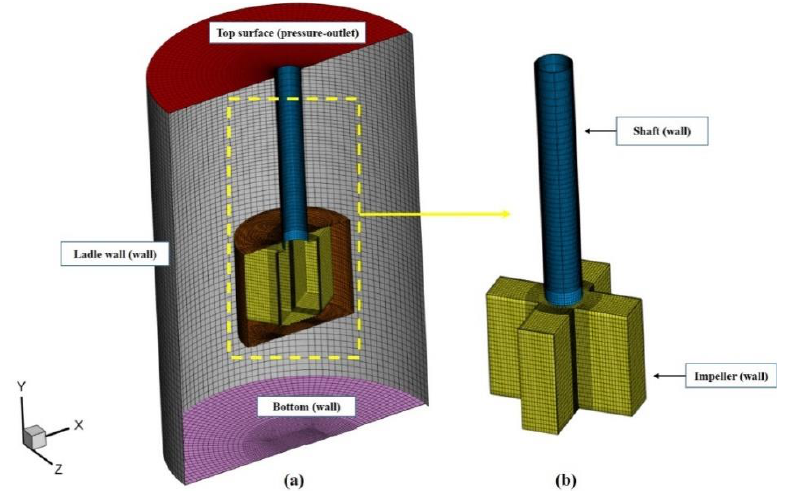
Figure 3. Numerical mesh of ( a ) central vertical profiles and ( b ) impeller.